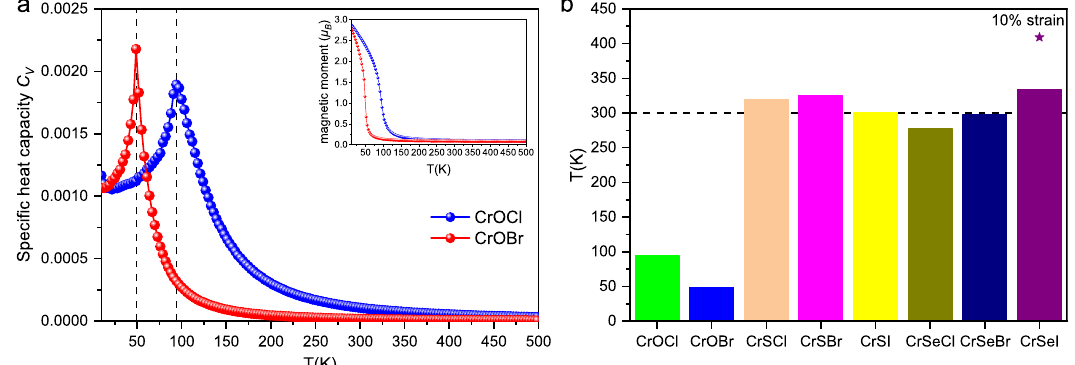
Fig. 7 Speci fi c heat capacity and Curie temperature of CrXY monolayers. a Evolution of the Monte Carlo speci fi c heat capacity of the CrOCl and CrOBr monolayers, the inset in ( a ) is the magnetic moment with the change of the temperature. b Curie temperature ( T c ) in CrXY monolayers.